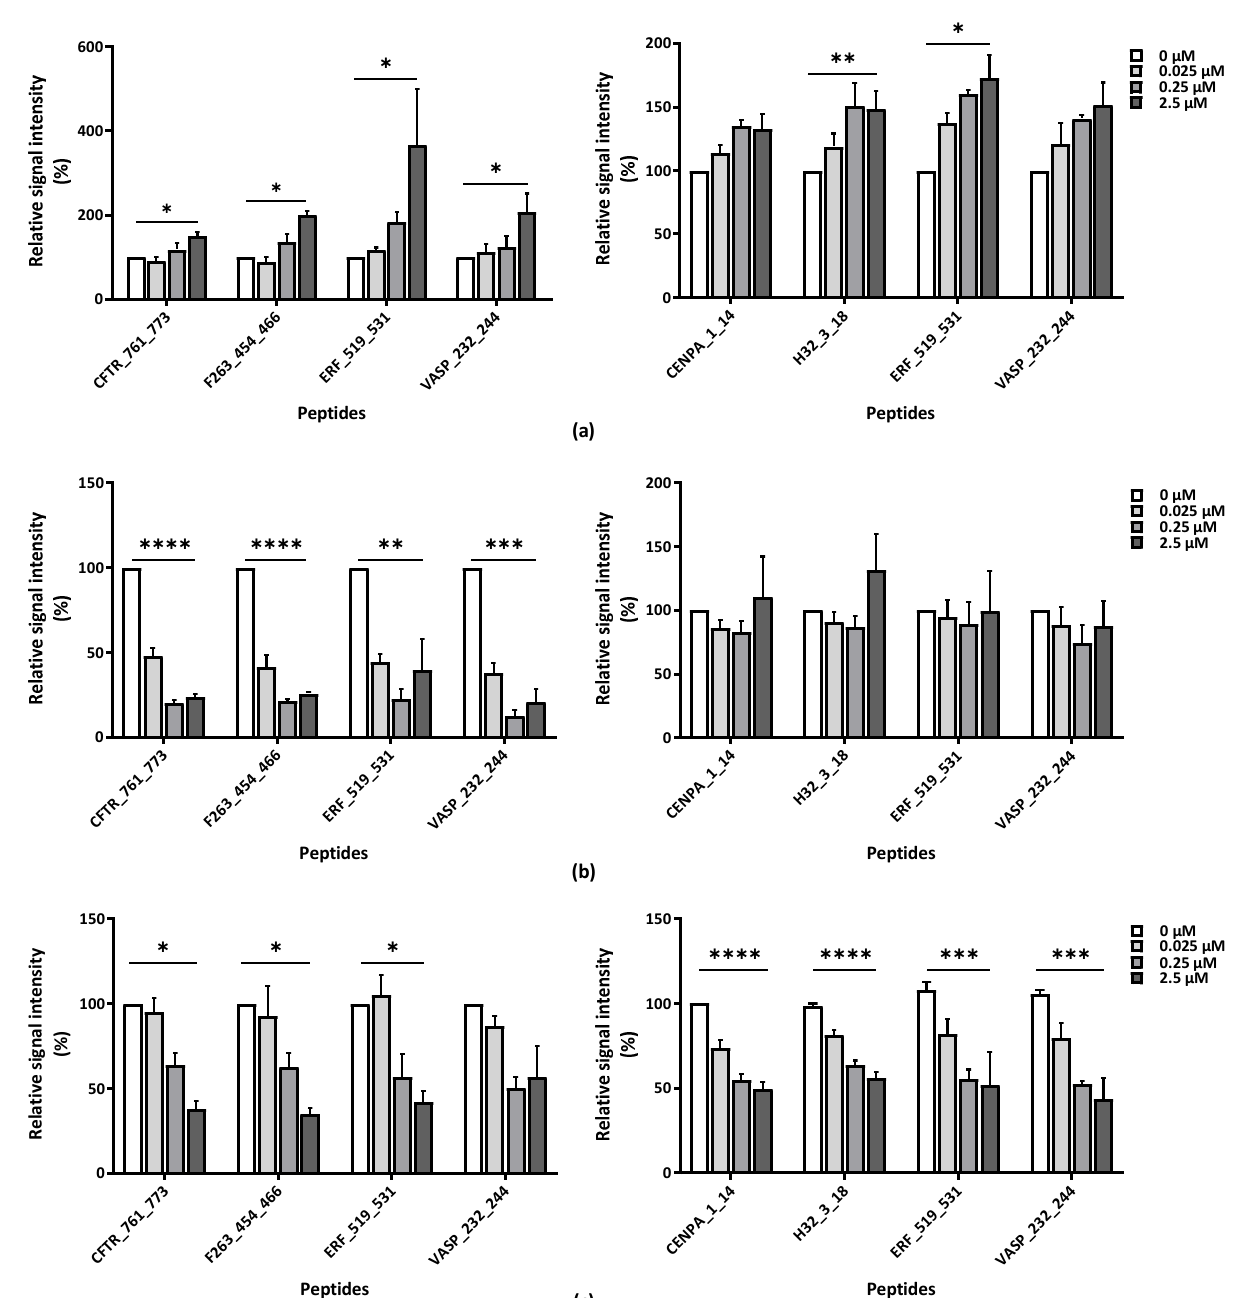
Figure 2. The effect of modulators on the activity of PKGI (left) and PKGII (right) for selected peptides: ( a ) PKG activator (8-Br-cGMP), ( b ) PKGI Inhibitor (Rp-8-Br-PET-cGMPS), and ( c ) pan-PKG inhibitor (Rp-8-pCPT-cGMPS). The concentration of the modulators was varied as indicated in the legend in the presence of 0.2 µ M cGMP. Relative signal intensity was measured in triplicate and expressed with respect to the condition without the modulator. The significant changes with modulators were determined with one-way ANOVA with significance indicated as * ( p ≤ 0.05), ** ( p ≤ 0.01), *** ( p ≤ 0.001) or **** ( p ≤ 0.0001) .